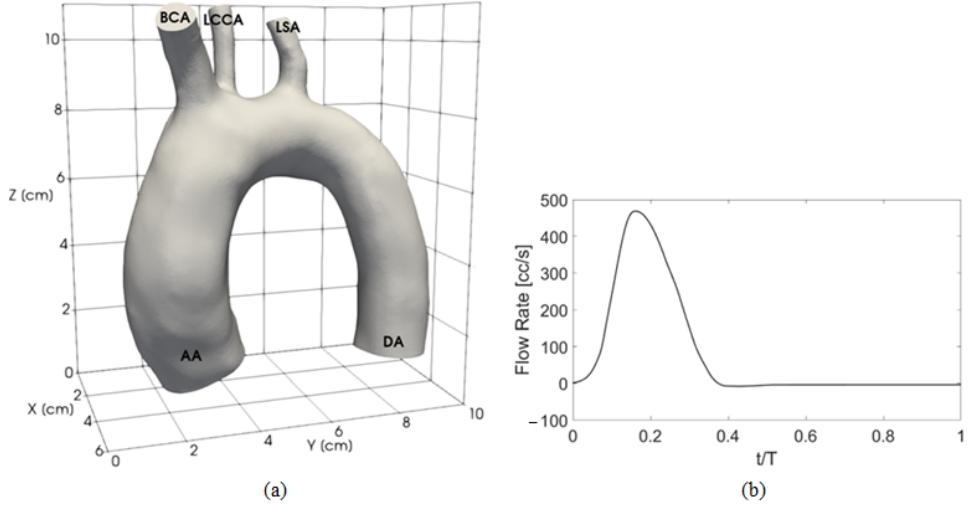
Figure 1. MRI-acquired ( a ) geometry of the healthy aorta and ( b ) inlet flow-rate